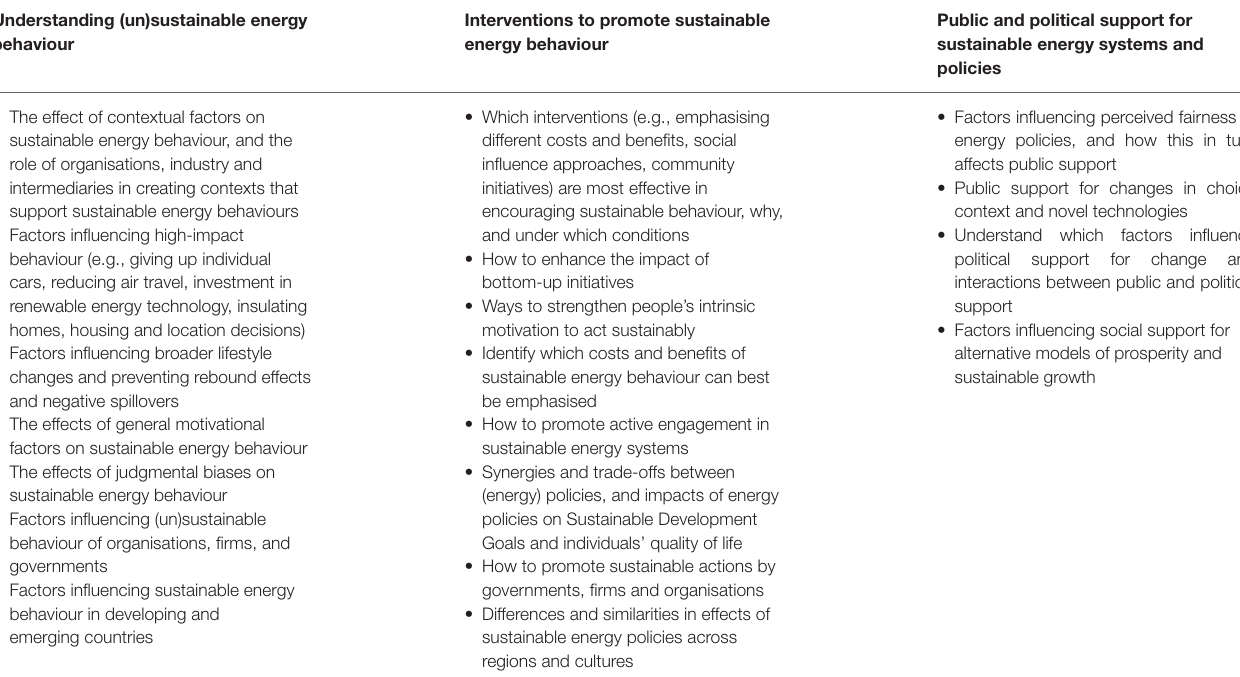
TABLE 1 | Thematic research agenda on the human dimensions of sustainable energy transitions: summary of key questions. Understanding (un)sustainable energy behaviour